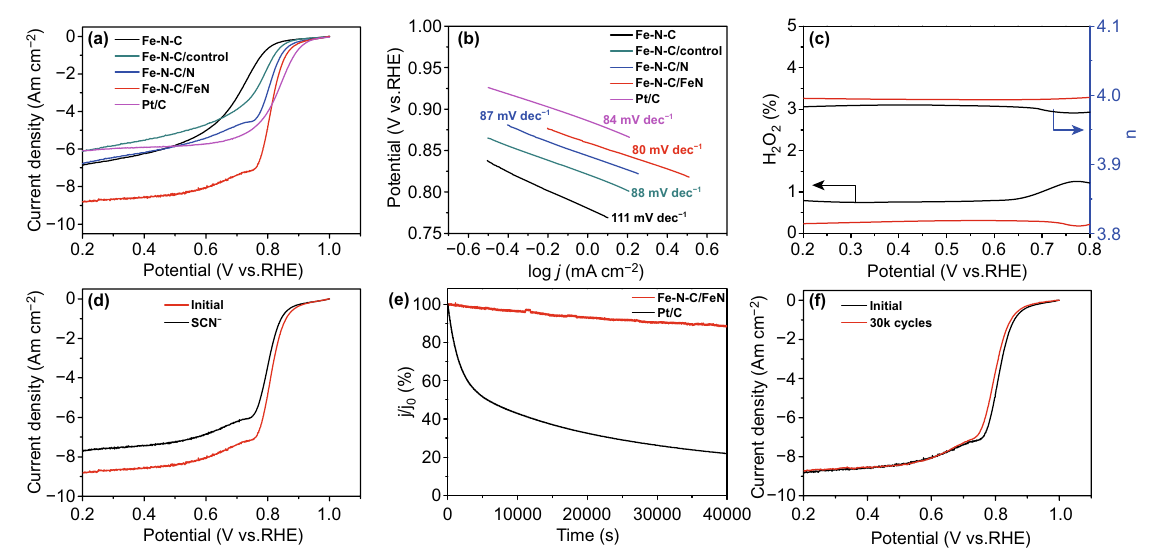
Fig. 5 a LSV curves and b Tafel slope curves of Fe–N–C, Fe–N–C/control, Fe–N–C/N, Fe–N–C/FeN and commercial Pt/C at 1600 rpm in O 2 -saturated 0.1 M HClO 4 solution (sweep rate: 10 mV s −1 ). c H 2 O 2 yield and electron transfer number of Fe–N–C/FeN (black) and commercial Pt/C (red). d LSV curves of Fe–N–C/FeN obtained without and with 5 mM KSCN. e Chronoamperometric response of Fe–N–C/FeN and com- mercial Pt/C. f ORR polarization plots of Fe–N–C/FeN before and after 30,000